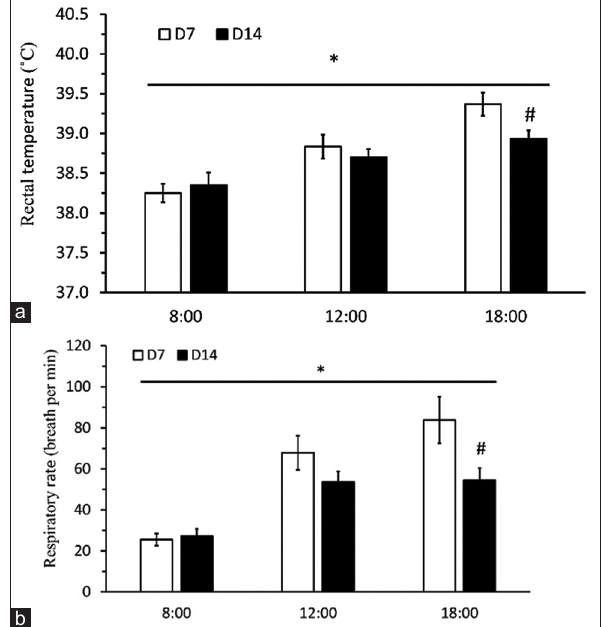
Figure-1: (a) The average rectal temperature (°C) and (b) the average respiration rate (breath per min) from day 7 (open bar) and day 14 (dark bar) at 8:00, 12:00, and 18:00. *The significant difference by two-way repeated analysis of variance (p < 0.05) and # the significant difference determined using Student’s t-test (p <